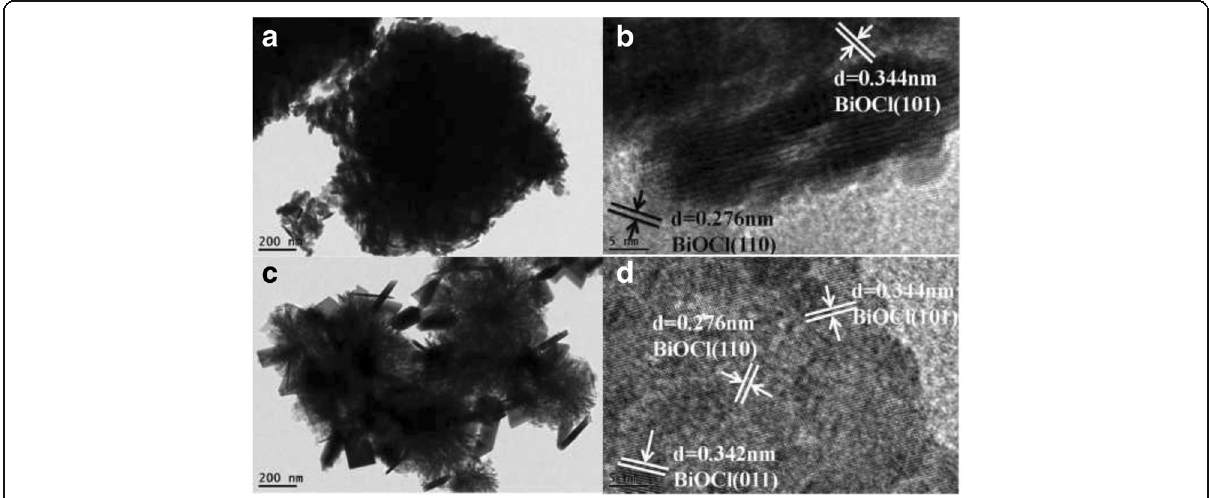
Fig. 3 TEM and HRTEM images of BiOCl ( a , b ) and Fe/BiOCl (0.25) ( c , d